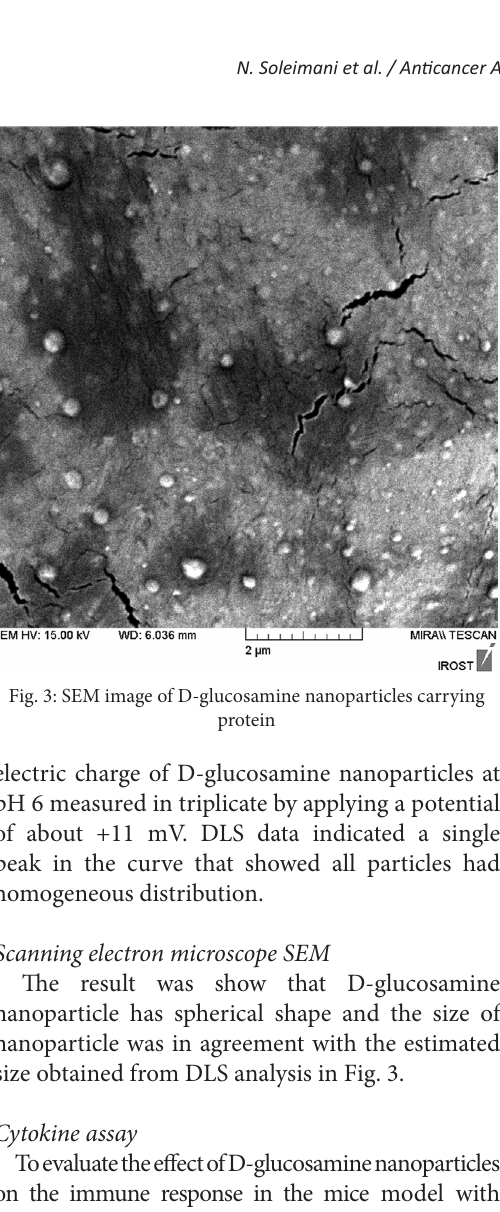
Fig. 4: The production of IL-4 levels in different mice groups under study (mean±SD) (P> 0.05).